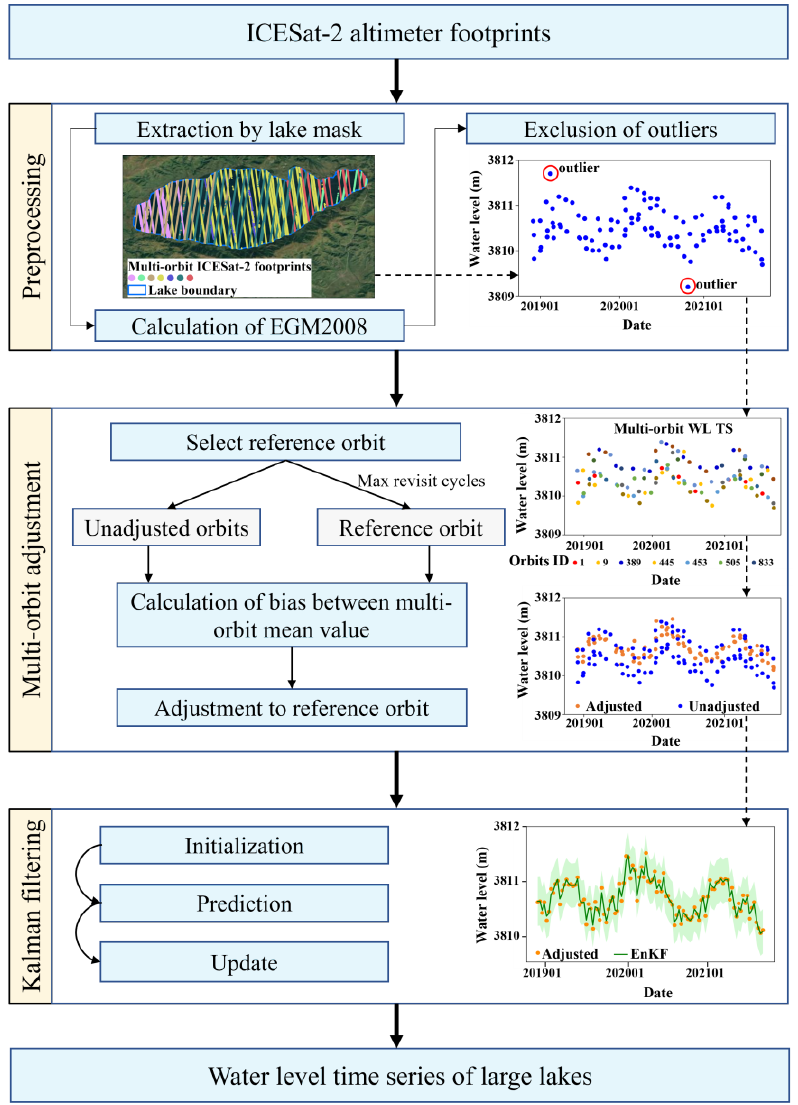
Figure 2. Flowchart for densifying and optimizing water level time series for large lakes by combining multi-orbit data derived from ICESat-2 altimeter. Solid arrows represent data processing and dashed arrows represent input or output data diagrams.